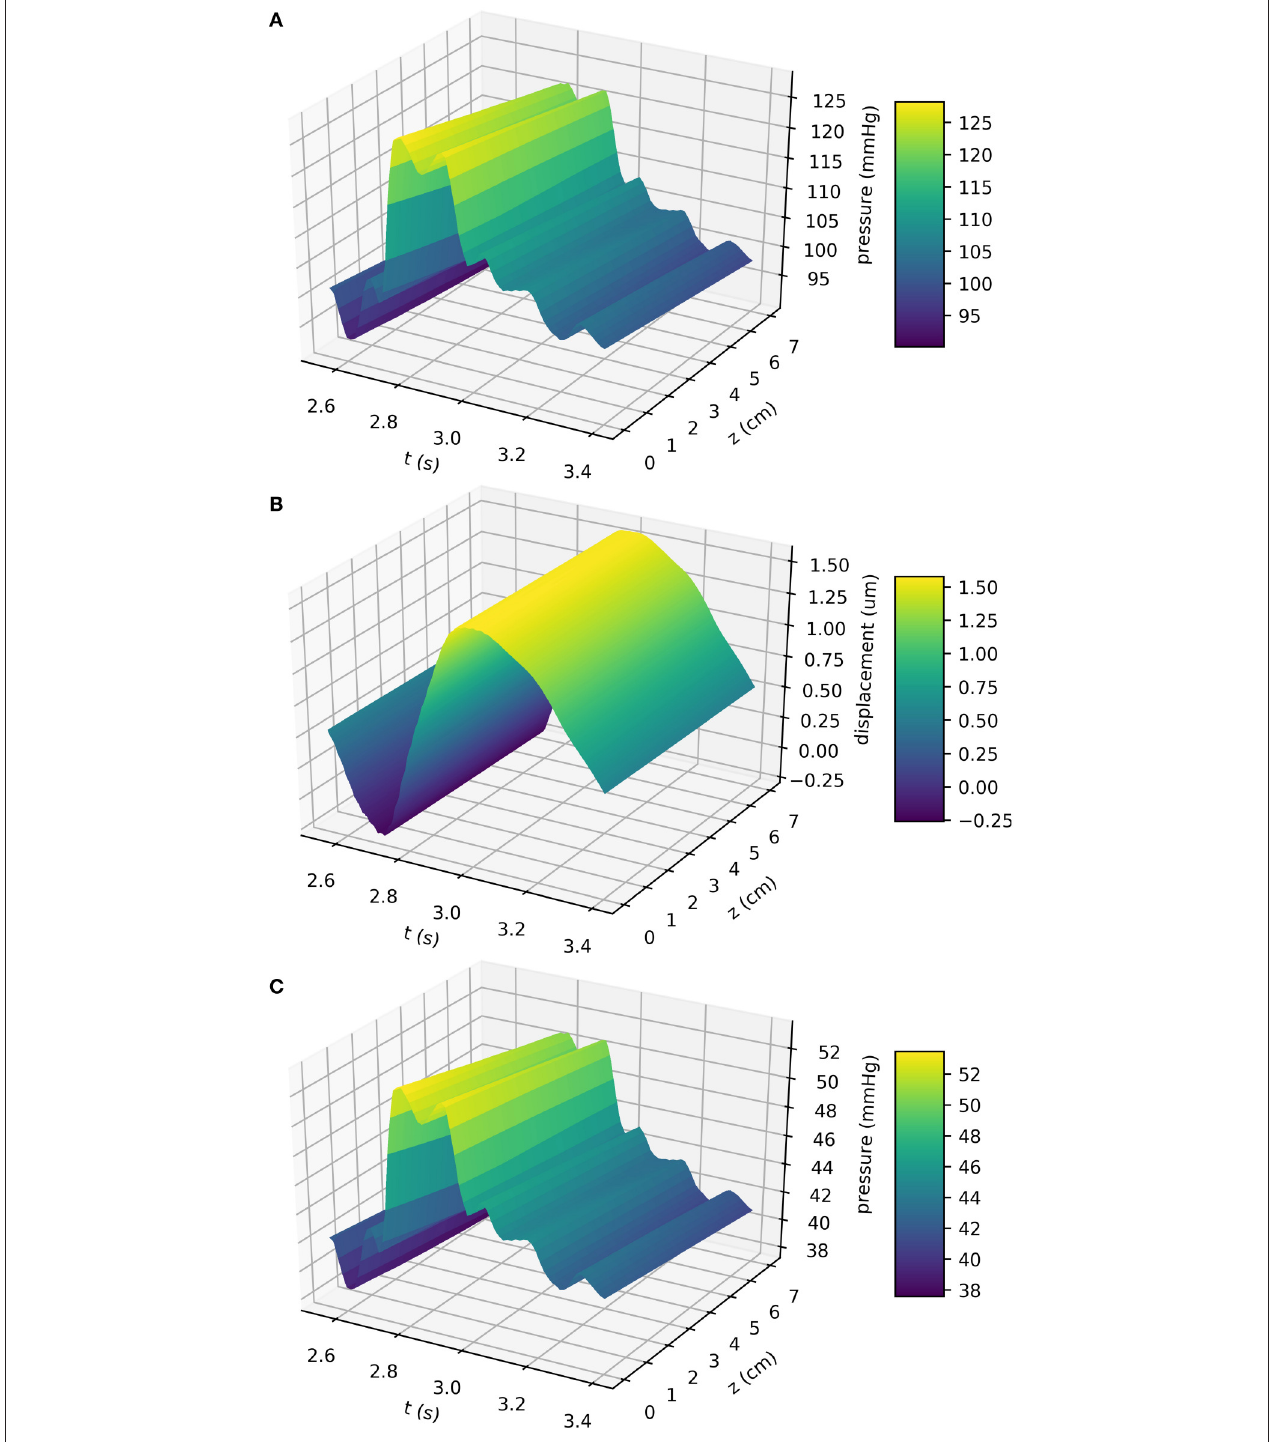
FIGURE 3 | Blood pressure (A) , wall displacement (B) , and the resulting ISF pressure (C) in the MCA. Simulations were performed using the VaMpy Python package (Diem and Bressloff, 2016) and the simulation parameters are listed in Table 2 . Wall stiffness is high in small blood vessels, therefore pressure gradients in time are steep. Wall displacement was calculated from the linear elasticity approximation derived in Supplementary Material 2. The input function R i ( z , t ) to the BM model Equation (6) is obtained by adding the radius at rest a (see geometry depiction in Figure 1 ).